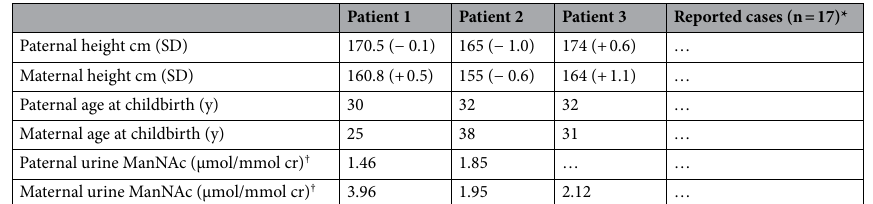
Table 1. Clinical findings in patients with NANS-CDG. y, year; m, month, w, week, SD, standard deviation; MRI, magnetic resonance imaging; ManNAc, N-acetylmannosamine, cr, creatinine; and P, percentile. *van Karnebeek et al. 1 and den Hollander et al. 2 . † Reference values: 15.0–35.0 for platelet, 1.1–6.1 for immature platelet fraction, < 46 for platelet associated IgG, 44–71 for sialic acids, and 0.71–3.99 for urine ManNAc; the reference value for ManNAc is derived from the data in 10 control subjects examined in this study (five children and five adults with no obvious difference between the children and the adults), and the remaining reference vales are based on the data of Special Reference Laboratories, Inc., Japan. ‡ Free plus glycoprotein- bound and glycolipid-bound sialic acid. For the frequency in reported cases, the denominators indicate the number of patients examined for the presence or absence of each feature, and the numerators represent the number of patients assessed to be positive for that feature. a Birth or present length/height ≤ − 2 SD or P 3. b No reference data for Japanese children ≤ 6 years. c Unknown because of post-tracheotomy. d A single patient (patient 8 in Hollander et al. 2 ) alone exhibits normal stature (P 44) and large weight (P 95). Footnote-1: External auditory canal stenosis, auditory disturbance, bulbous nasal tip, megaloglossia, short neck, and thoracic dysplasia. Footnote-2: Thinning of cortex and white matter, and narrowed cerebral aqueduct. Footnote-3: Intermittent exotropia, hyperopia, brachycephaly, hypertelorism, anteverted nares, short philtrum, protruding ears, and cup shaped